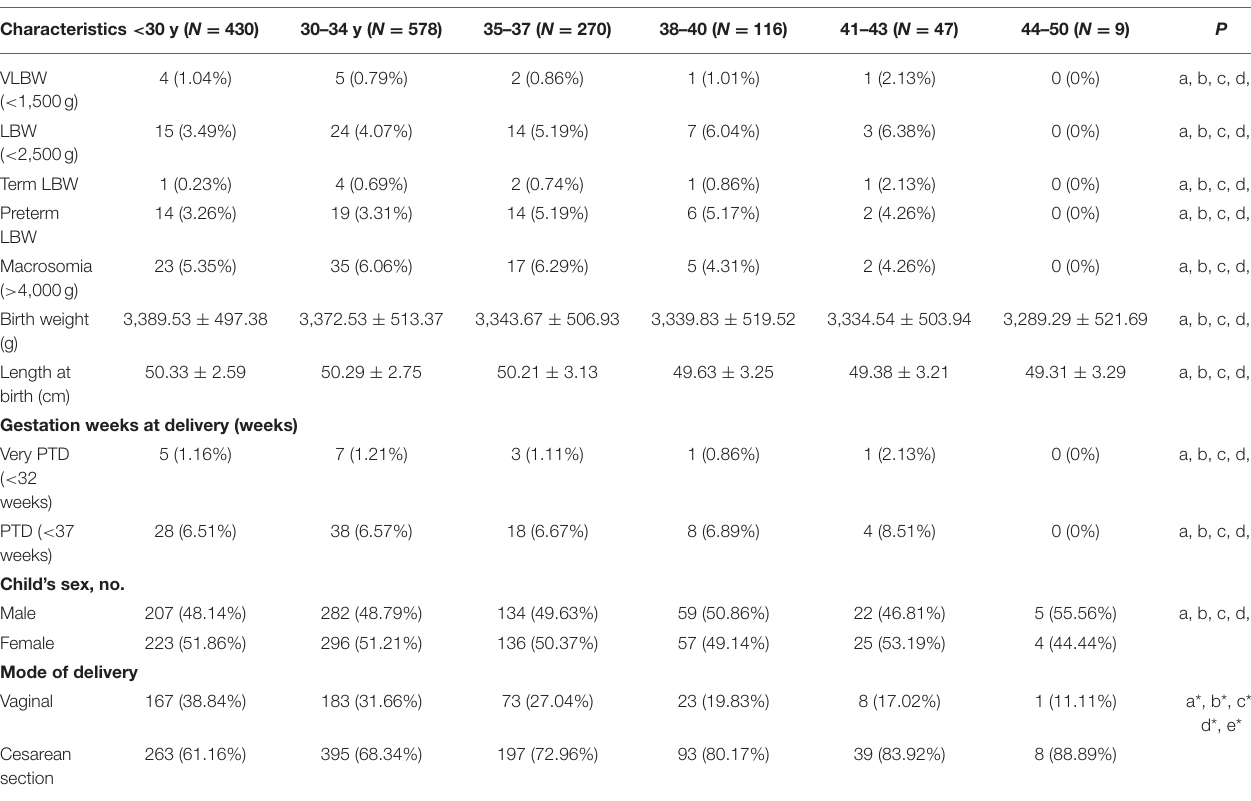
TABLE 3 | Neonatal outcomes of live born singletons. Characteristics < 30 y ( N =